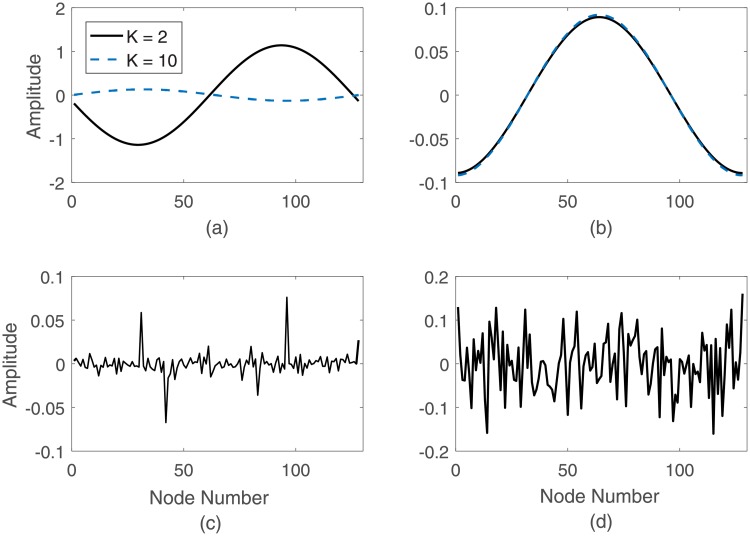
Signal representation of binary network.Top: Signal representation of a k-regular graph with degree K = 2 and K = 10; a. Resistance distance measure (R), b. Distance measure (D); Bottom: Signal representation of an Erdős-Rènyi network with probability of attachment p = 0.5; c. Resistance distance measure (R), d. Distance measure (D). For all networks N = 128.